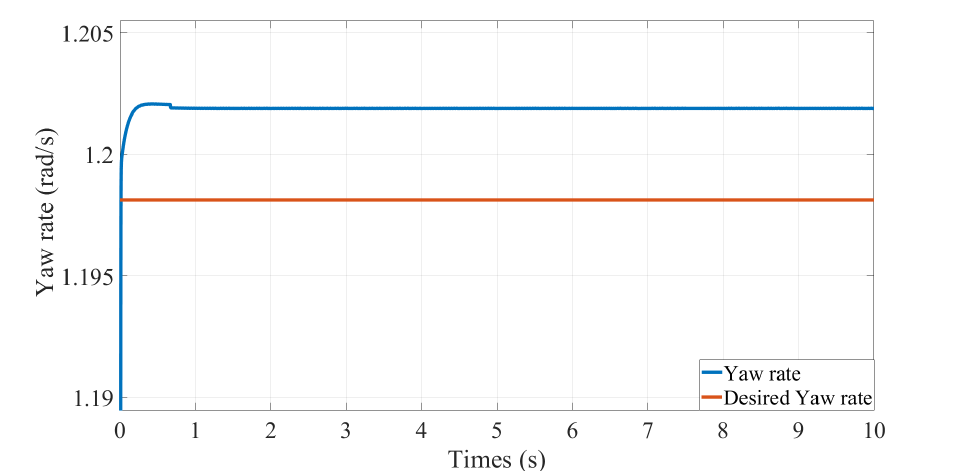
Figure 14. Controlled yaw rates with SMC and constant input.